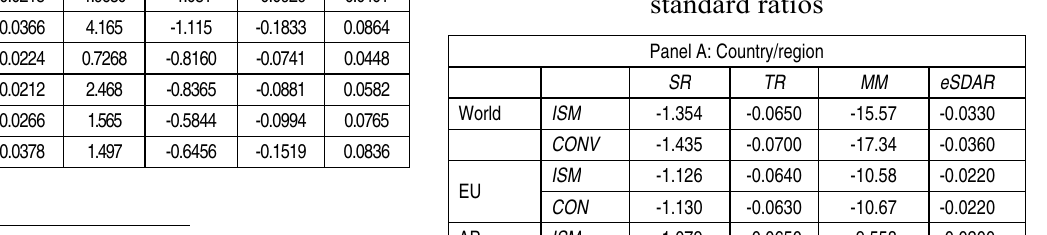
Table 5. Financial performance evaluation